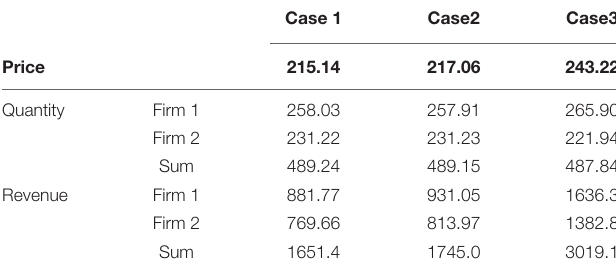
TABLE 3 | Market clearing results under different